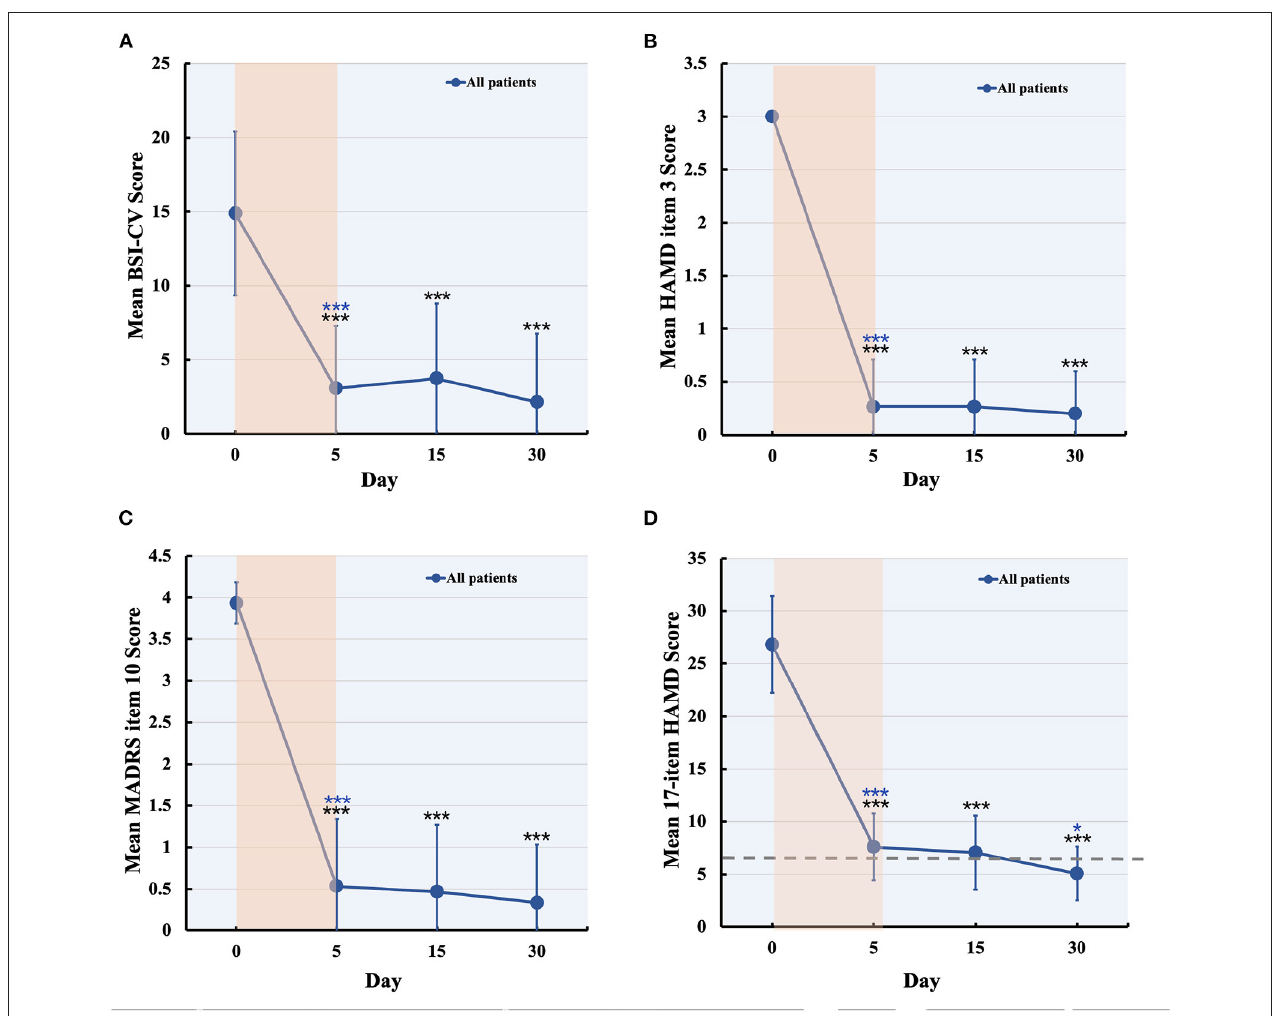
FIGURE 3 | Changes in suicidal and depression score during and after IT-TMS therapy for MDD patients with SI. Panel (A–C) shows the suicidal assessment scale of BSI-CV, item 3 of HAMD, and item 10 of MADRS, for patients’ baseline (day 0), just post-therapy (5 days), 15, and 30 days post IT-TMS therapy. Panel (D) was the mean score of the 17-item HAMD for all patients at baseline (day 0), just post-therapy (5 days), 15, and 30 days post IT-TMS therapy. Black asterisks, significance is compared with baseline; blue asterisks, significance is compared with previous time point. BSI-CV, Beck Scale for Suicide Ideation-Chinese Version; HAMD, Hamilton Depression Rating Score; MADRS, Montgomery–Asberg Depression Rating